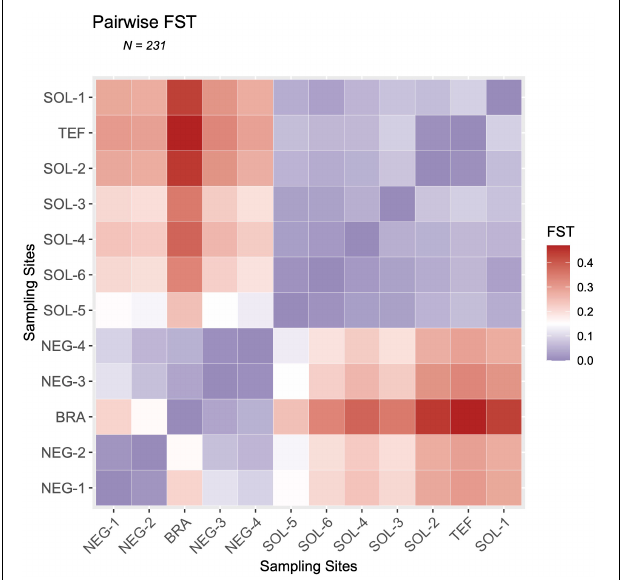
FIGURE 3 | Pairwise Fst/(1 - Fst) heatmap of the Fst values between the 12 sampling sites of Mesonauta festivus in the Amazon basin. Fst values were estimated using the stamppFst function in R with 100 bootstraps and assuming four genetic clusters. Fst values represent the genetic differentiation between each pair of sites, a value of one meaning that the populations are completely differentiated and a value of zero meaning that they are identical. Sites were ordered according to their watershed of origin. For NEG-1, SOL-6, SOL-5, SOL-3, NEG-4, BRA, TEF, SOL-2 and SOL-1 ( n = 20), for NEG-3 ( n = 19), and for SOL-4 and NEG-2 ( n = 16).